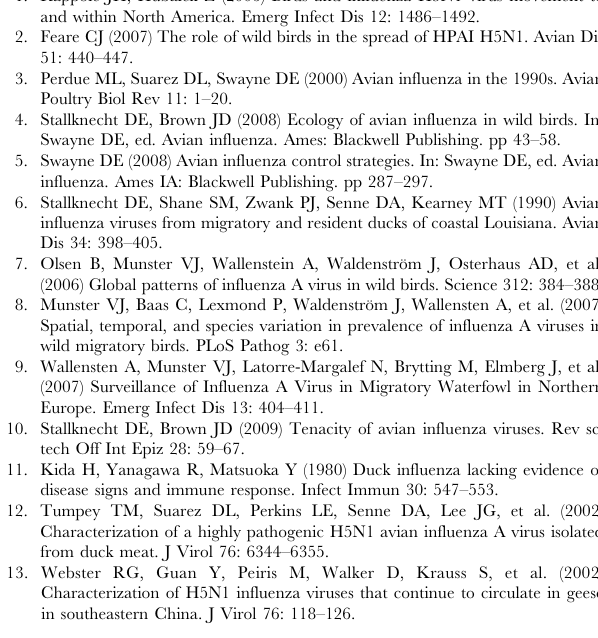
Figure S2 Cumulative recovery and mortality probabilities after infection. Lines with markers are cumulative probabilities of young (black) and adult (grey) birds from laboratory challenges. Corresponding lines without markers are the predicted cumulative